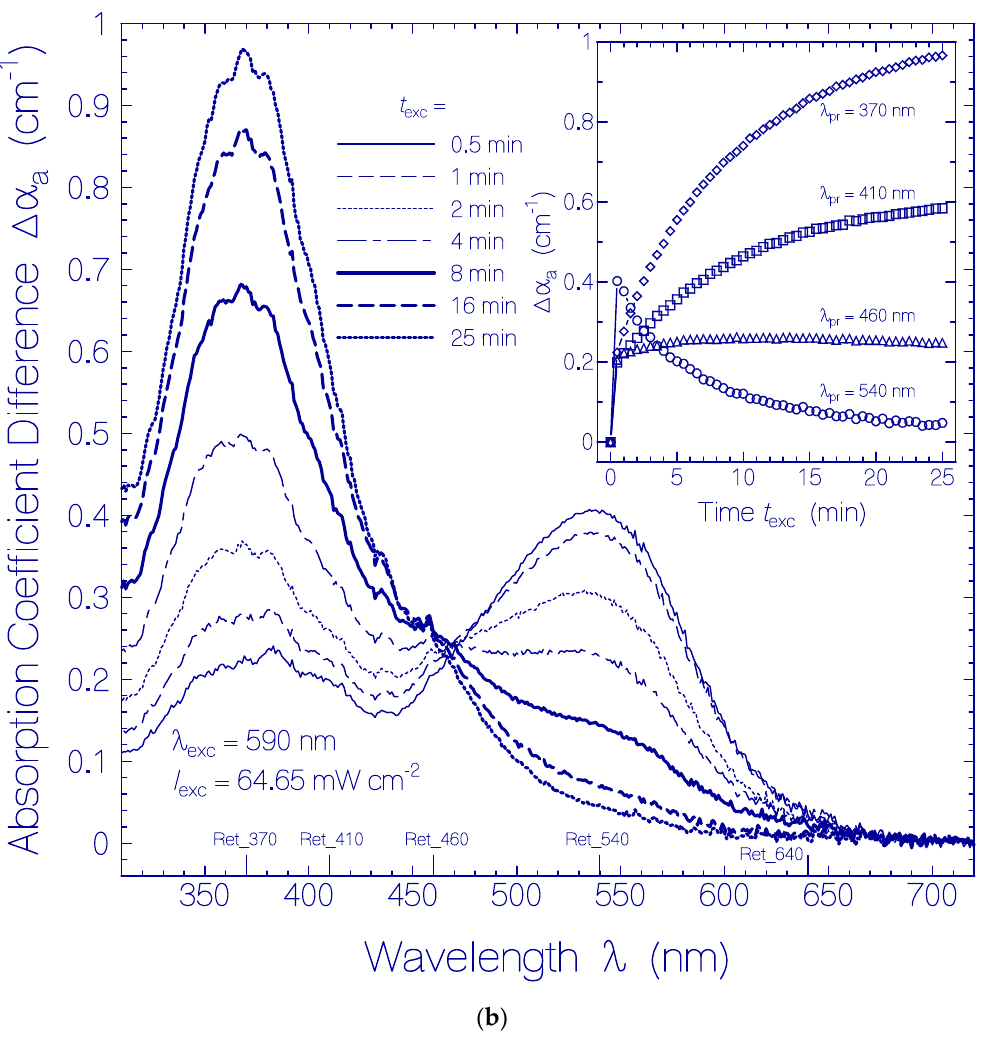
Figure 1. ( a ) Development of absorption coefficient spectra of a QuasAr1 sample in pH 8 Tris buffer during light exposure with LED 590 nm with input excitation intensity of I exc = 64.65 mW cm − 2 . The durations of light exposure are listed in the figure. The triple dotted curve named Ret_580 ( t exc = 0) in the wavelength range >310 nm shows the absorption coefficient contribution of Ret_580 to QuasAr1 before light exposure (taken from Figure 1 in [33]). The dashed triple-dotted curve named Residuals shows the absorption coefficient contribution of residual retinal isomers in QuasAr1 other than Ret_580 (taken from Figure 1 in [33]). The curve g LED 590 nm ( λ ) = S LED 590 nm ( λ )/ S LED 590 nm ( λ max ) shows the spectral distribution of the excitation light source LED 590 nm. The inset shows the temporal dependence of α a (620 nm) versus exposure time t exc . The data points are fitted by α a ( t rec ) = α a ( 0 ) − ∆ α I [ 1 − exp ( − t exc / τ sat , I )] − ∆ α II [ 1 − exp ( − t exc / τ sat , II )] with α a (0) = 1.554 cm − 1 , ∆ α I = 0.436 cm − 1 , τ sat,I = 0.015 min, Δα II = 1.03 cm − 1 , and τ sat,II = 8.65 min. ( b ) Absorption coefficient spectra of formed species of QuasAr1 in pH 8 Tris buffer due to light exposure with LED 590 nm of input intensity I exc = 64.65 mW cm − 2 . The absorption contributions of Ret_580, α aRet_580 ( λ , t exc ), and of the initial residuals, α a,Residuals ( λ ,0), from Figure 1a are subtracted, i.e., ∆ α a ( λ , t exc ) = α a ( λ , t exc ) − α a ,Ret_580 ( λ , t exc ) − α a ,Residuals ( λ , t exc = 0 ) . The approximate peak wavelength positions of the retinal isomers Ret_640, Ret_540, Ret_460, Ret_410, and Ret_370 are indicated at the bottom. The inset shows the temporal development of ∆ α a at λ pr = 540 nm, 460 nm, 410 nm, and 370 nm versus exposure time t exc .